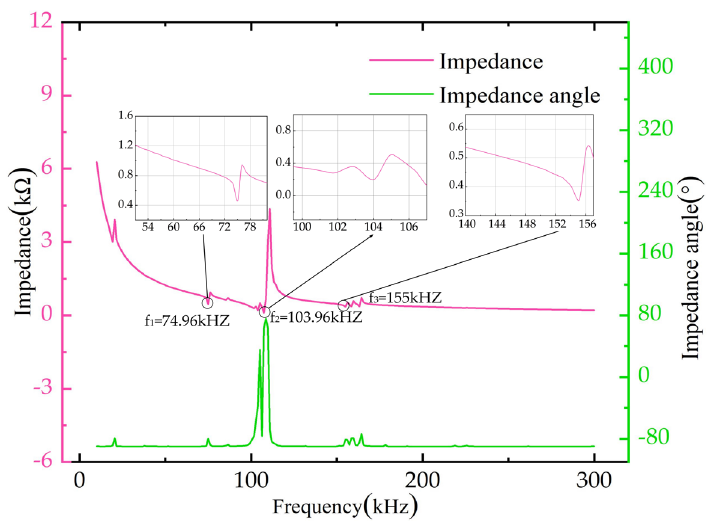
Figure 8. Impedance and phase curves of atomization sheet with frequency.